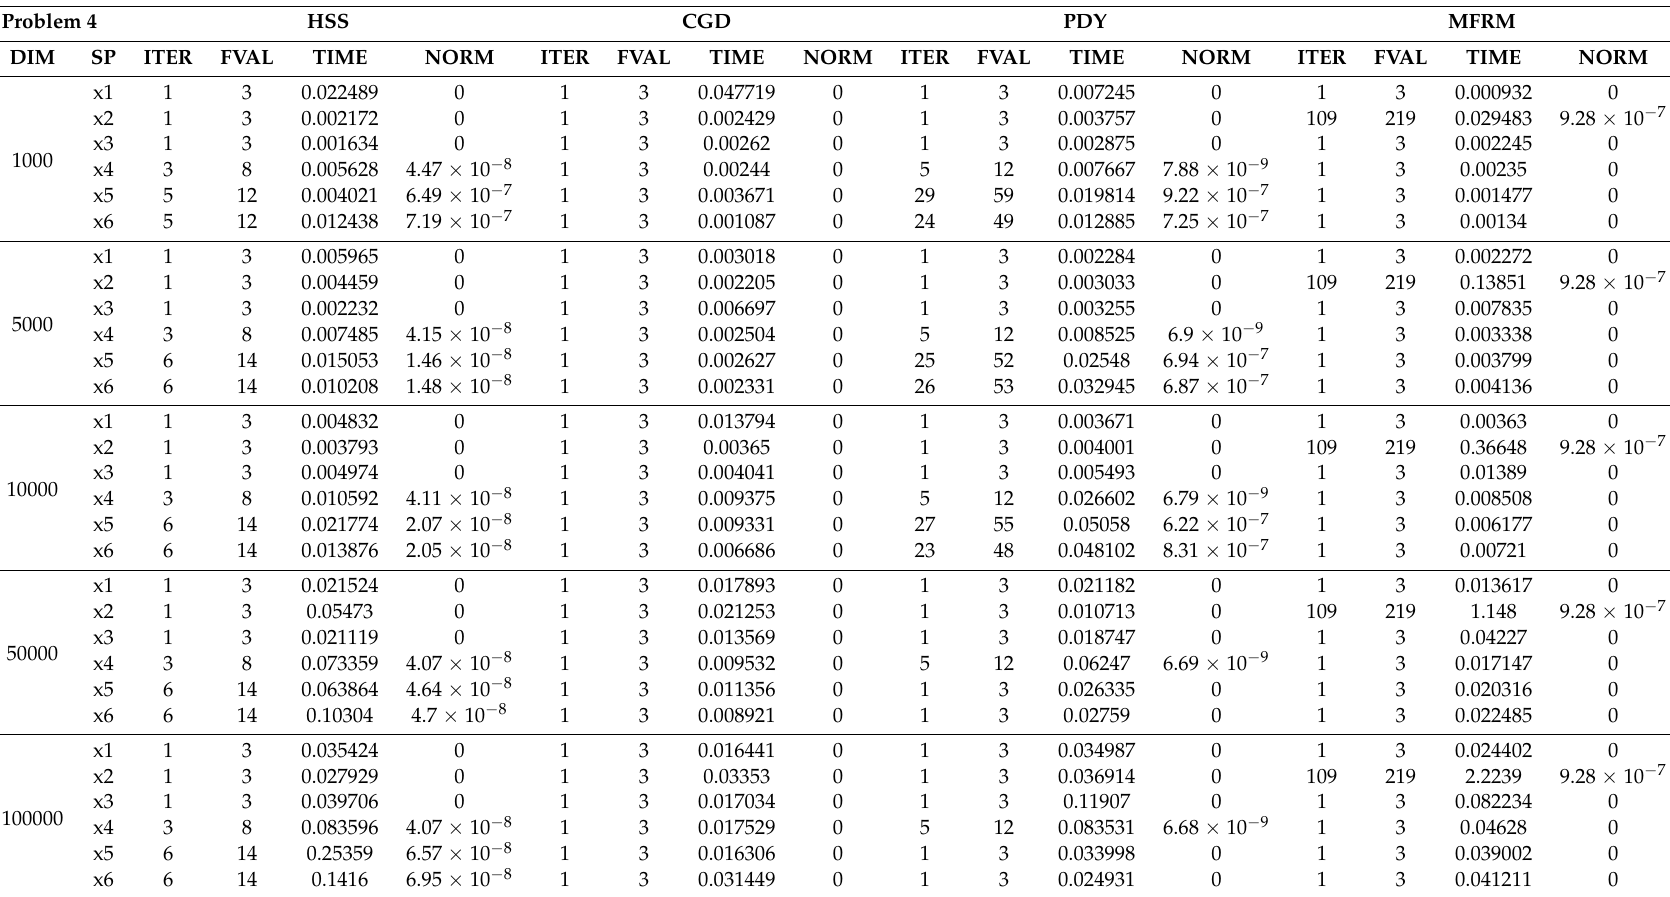
Table 4. Test results obtained by the four solvers for Problem